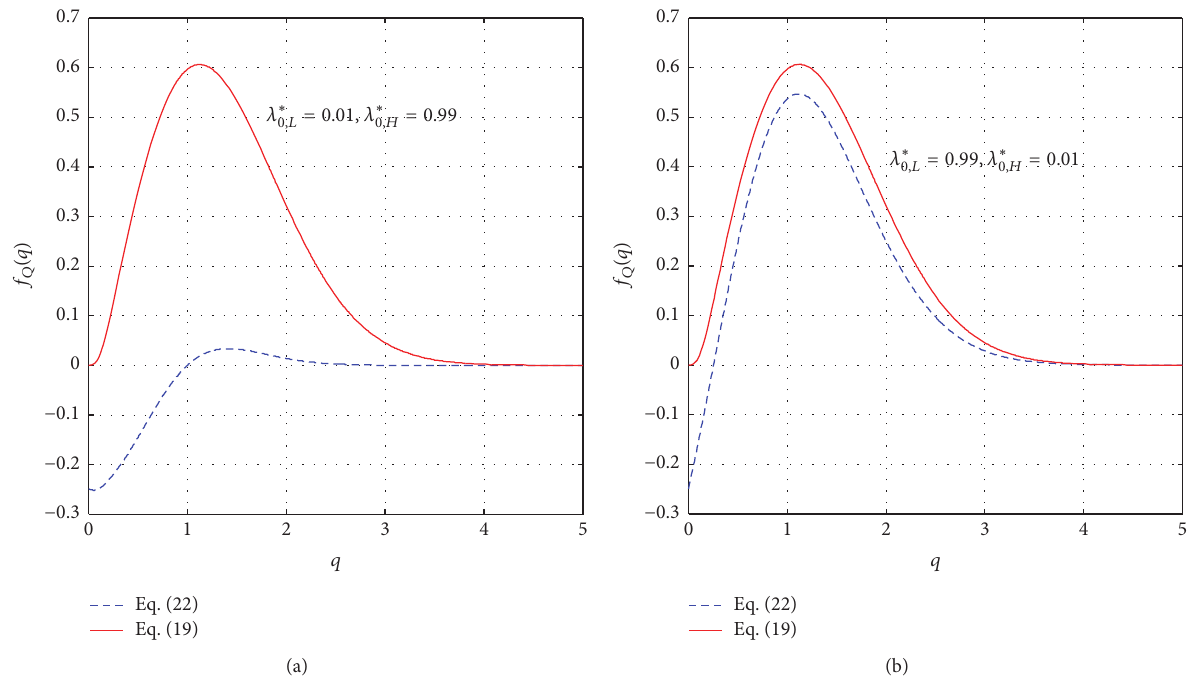
Figure 3: The divergence of (19) and (22) for JM method in case of (a) 𝜆 ∗ 0,𝐿 = 0.01 and (b) 𝜆 ∗ 0,𝐿 = 0.99